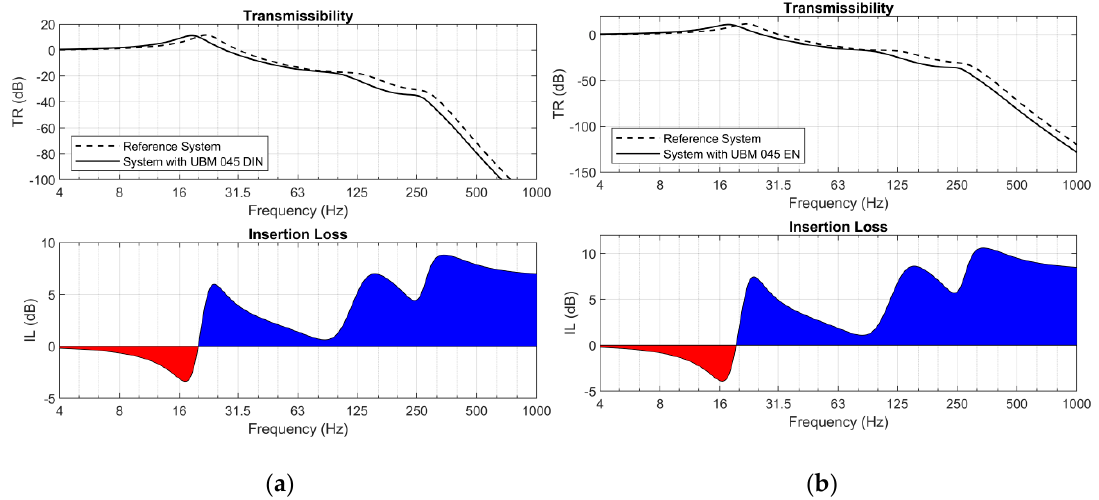
Figure 13. Transmissibility (TR) and insertion loss (IL)—reference system and system with UBM 045: ( a ) according to EN [24]; ( b ) according to DIN [23].